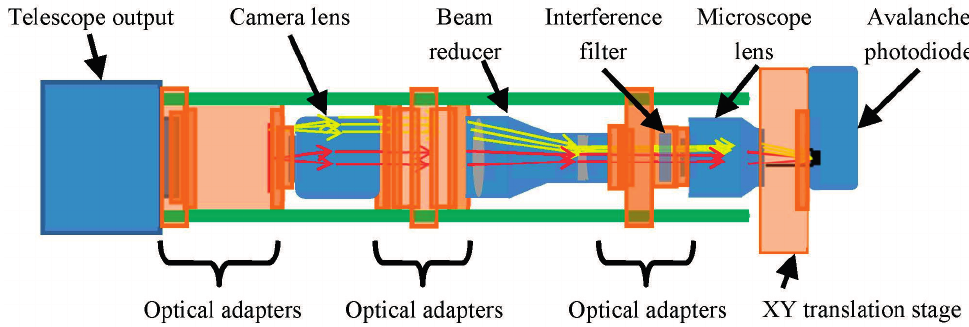
Figure 7. Lidar light collection optics from the rear of the telescope to the APD